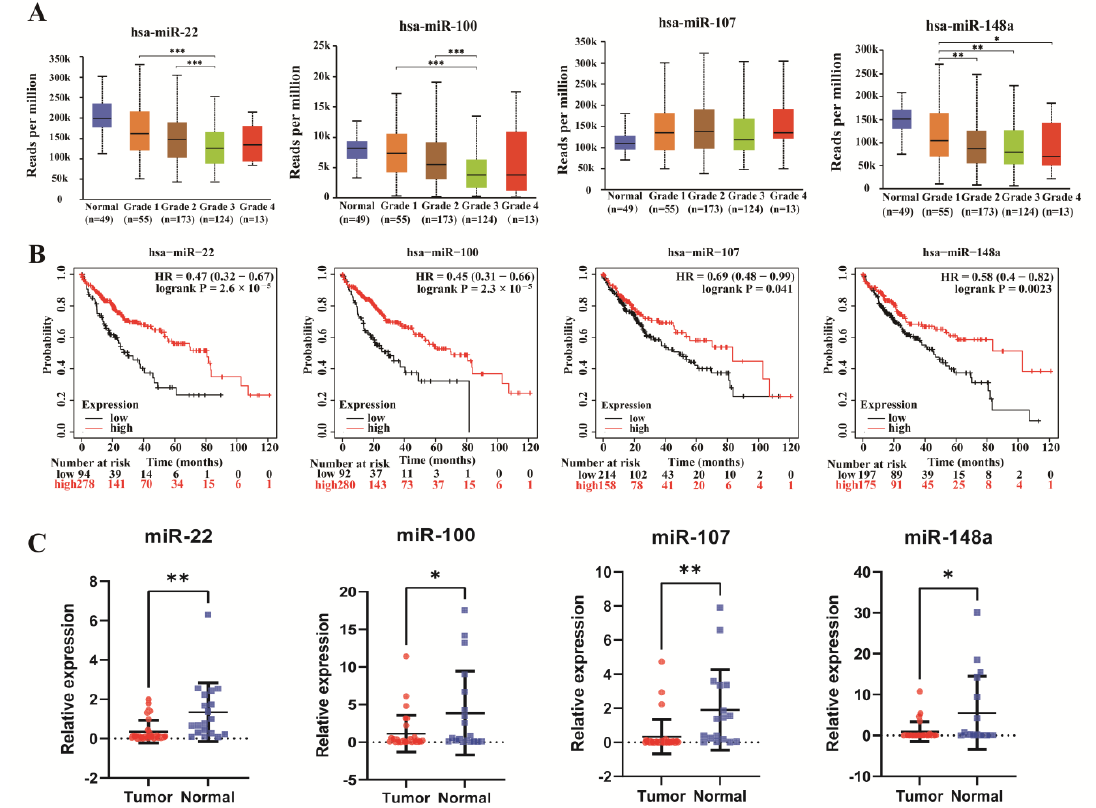
Figure 6. Comprehensive analysis of the key miRNAs ( A ) The miRNA expression with tumor grade in HCC. ( B ) Survival analysis of miR-22, miR-100, miR-107, and miR-148a in 371 HCC tissues. ( C ) Expression patterns of miR-22 ( p = 0.0012), miR-100 ( p = 0.0203), miR-107 ( p = 0.0018), and miR-148a ( p = 0.0154) in HCC and health groups (HCC: n = 40; healthy: n = 20). Data are shown as means ± SD, * p < 0.05, ** p < 0.01, *** p < 0.001.